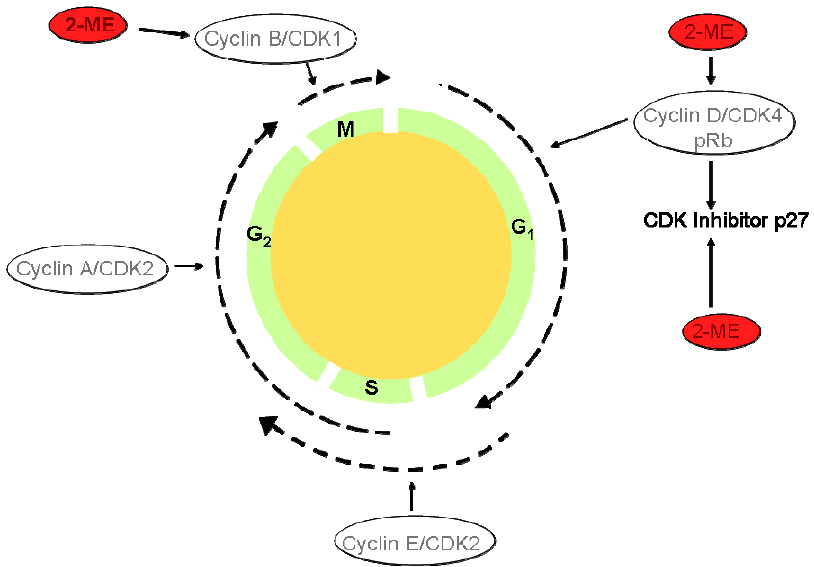
Figure 9. The eukaryotic cell cycle (adapted from